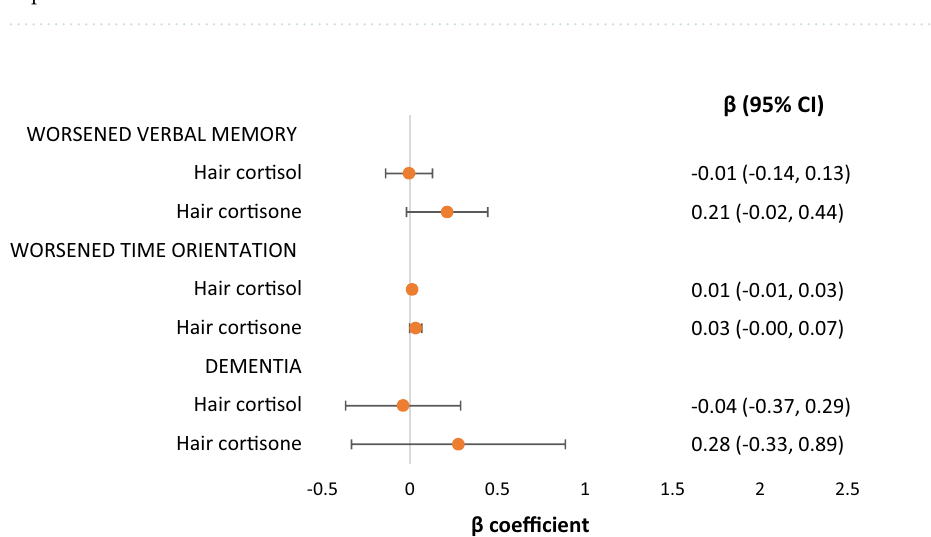
Table 4. Adjusted regression models of hair cortisone as the exposure and cognitive performance and dementia as the outcomes. *P < 0.05, **P < 0.01, ***P < 0.001. a Linear random effect models were used to investigate the associations between hair cortisone and worsened verbal memory and time orientation. b Cox regression model was used to investigate the association between hair cortisone and dementia. c Age and depression score were treated as continuous variables.